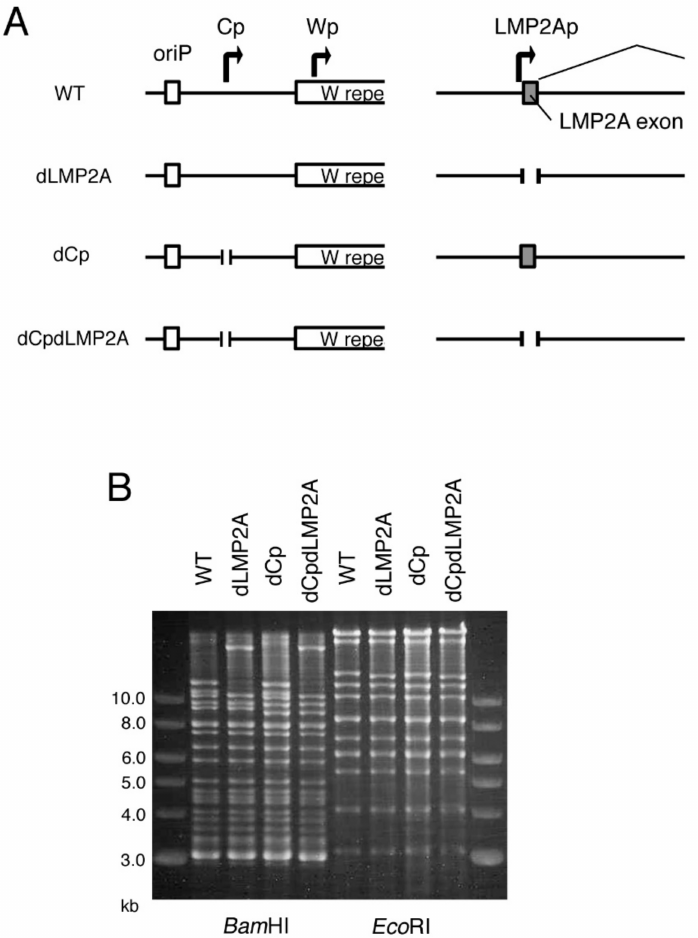
Figure 6. Construction of the latent membrane protein 2A-deficient (dLMP2A) and Cp/LMP2A double knockout (dCpdLMP2A) EBV mutants using the EBV-BAC system. ( A ) Schematic diagram of the EBV-BAC recombinant viruses. The first exons of the LMP2A gene of WT and dCp EBV constructs were removed to prepare dLMP2A and dCpdLMP2A, respectively. ( B ) Recombinant EBV-BAC DNA was digested by BamHI and EcoRI, and the products were examined by agarose gel electrophoresis. After transfection into HEK293 cells, recombinant viruses were prepared and titrated, followed by normalization of the titer, and infected to PBMCs (Figure 7). Deletion of Cp